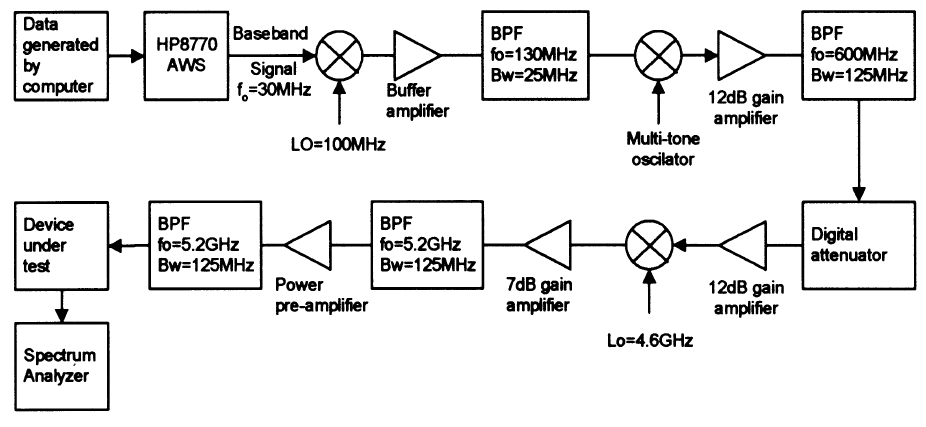
FIGURE 1 Block diagram of the